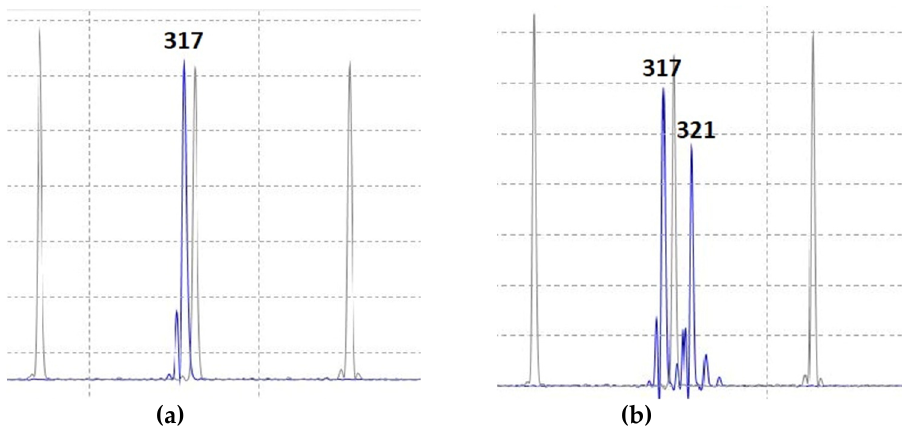
Figure 5. Identification of the allelic state of DDW1 using fragment analysis of the REMS1218 marker amplicons: tall ddw1 allele ( a ) and dwarfing Ddw1 allele ( b ).